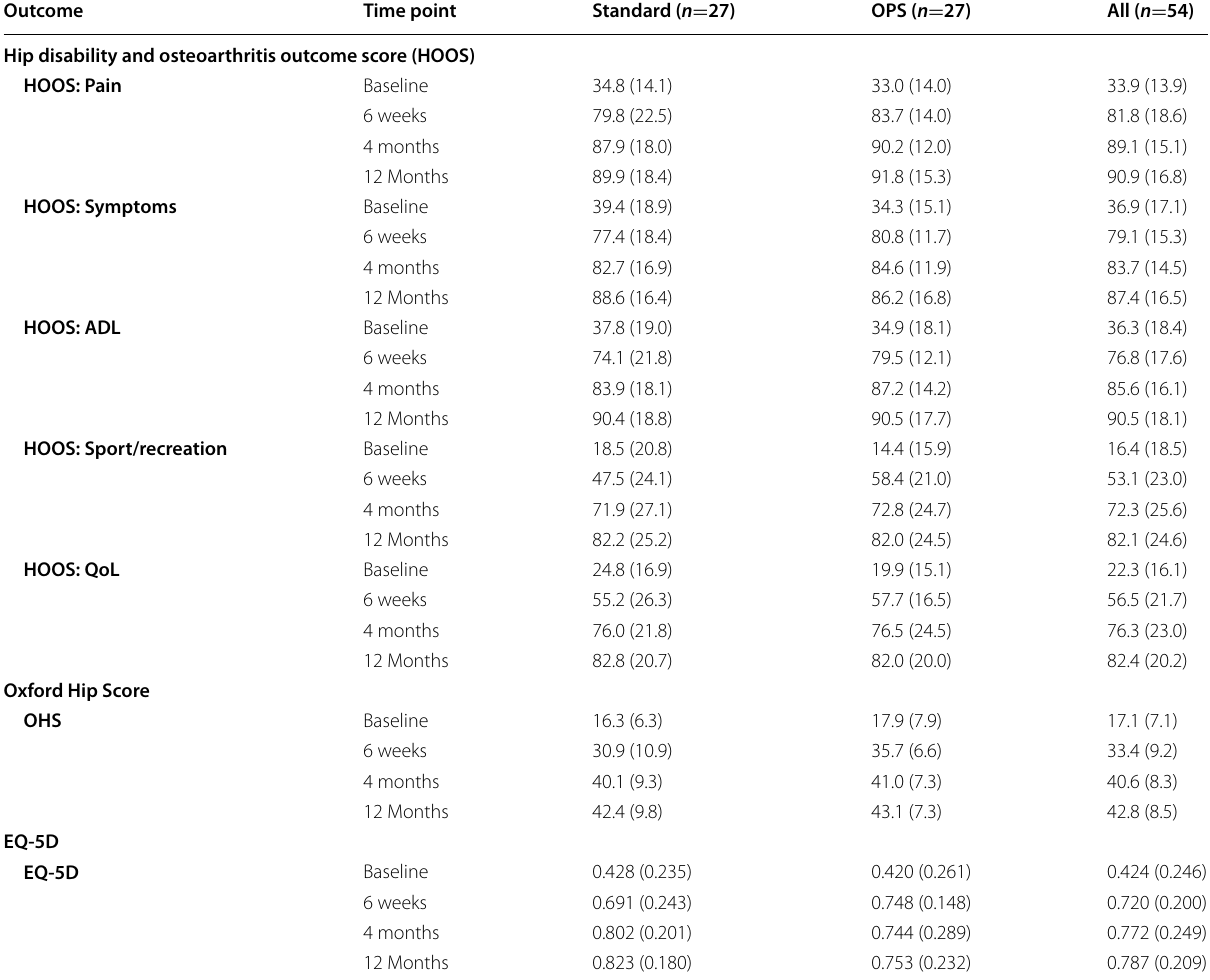
Table 3 Baseline, 6-week, 4- and 12-month follow-up HOOS, OHS and EQ-5D scores Outcome Time point Hip disability and osteoarthritis outcome score (HOOS)